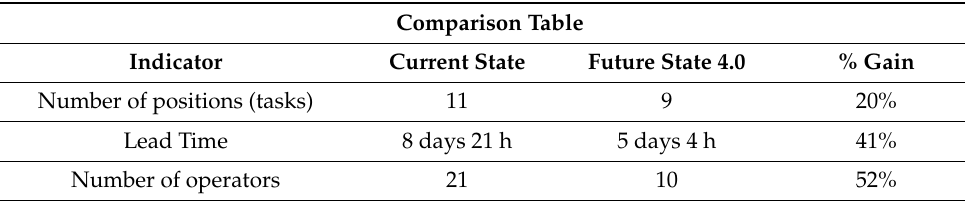
Table 7. Gain between current state and future state 4.0.